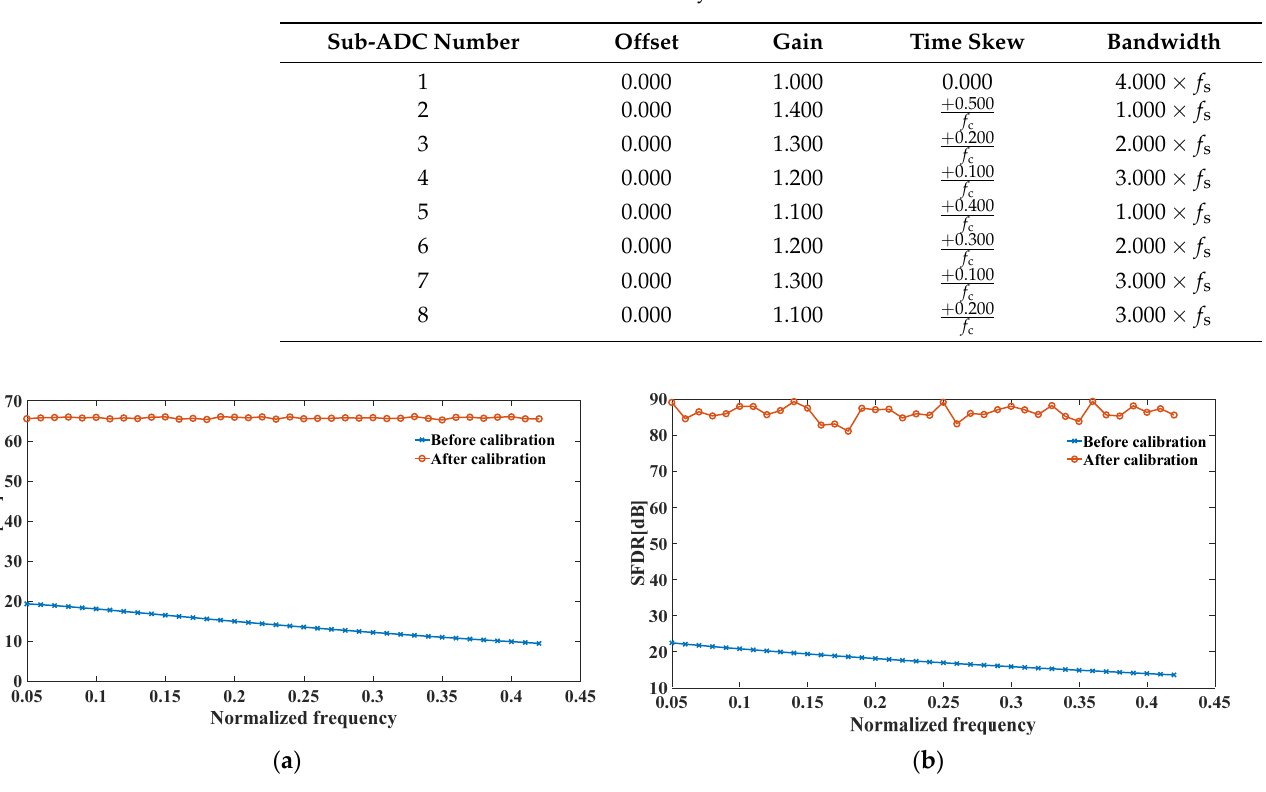
Figure 8. Performances of the proposed method in the second Nyquist bandwidth of the sub ‐ ADC. ( a ) The SNDR of TI ‐ ADCs with different frequencies; ( b ) the SFDR of TI ‐ ADC with different frequencies. Figure 9. Performances of the proposed method in the third Nyquist bandwidth of the sub ‐ ADC. ( a ) The SNDR of TI ‐ ADCs with different frequencies; ( b ) the SFDR of TI ‐ ADC with different frequencies.